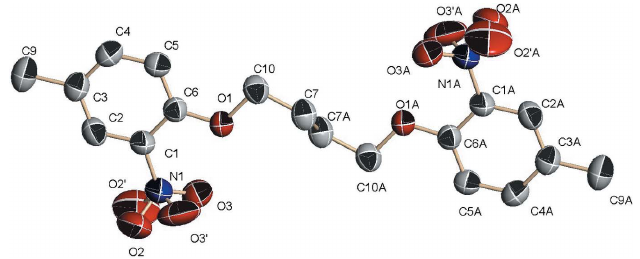
Table 2 Experimental details.